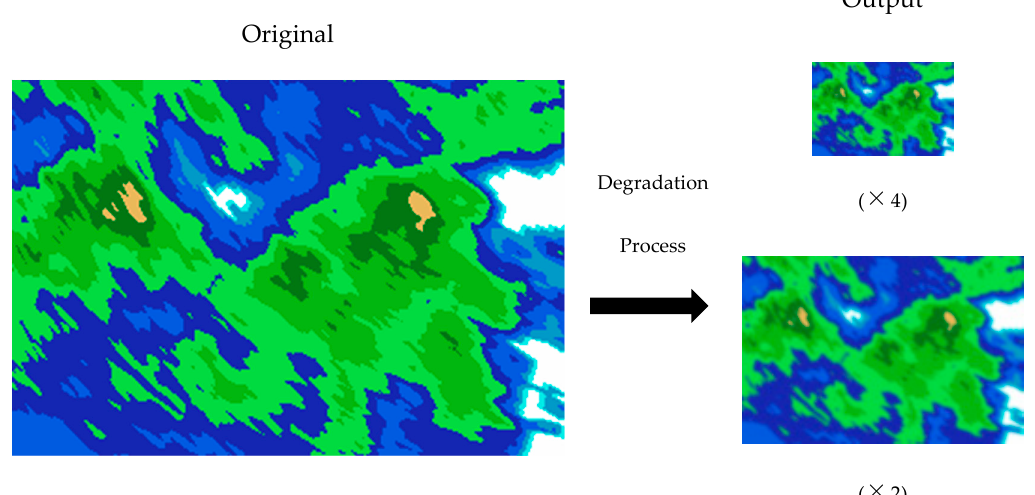
Figure 5. Example of a high-resolution echo image patch (Figure 4a) and the output low-resolution patch from the degradation process.